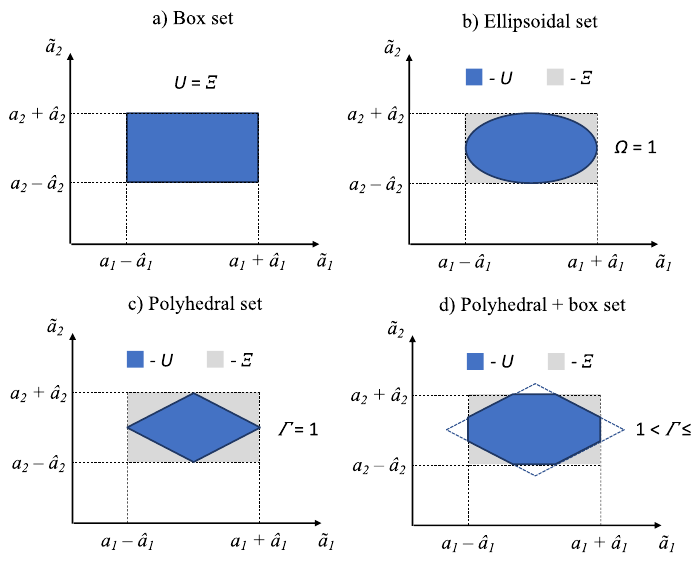
Figure 1. Uncertainty set U for a constraint with two uncertain parameters.